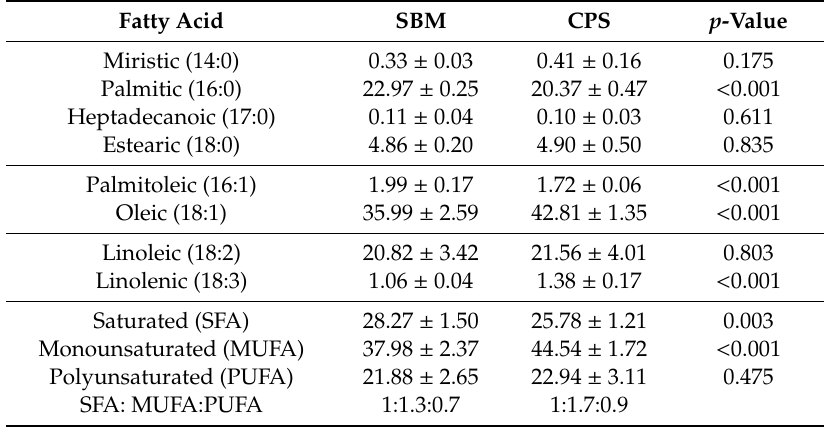
Table 4. Fatty acids proportions (%) in the subcutaneous fat tissue of broiler chickens fed soybean meal and chickpea